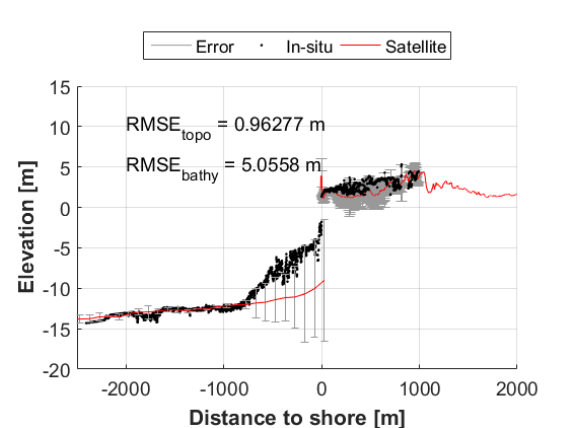
Figure 5. Comparison of in situ (black) and satellite-derived data (red) on a longshore median transect. The alongshore error between in-situ measurements and satellite estimate is represented as error bars (gray)